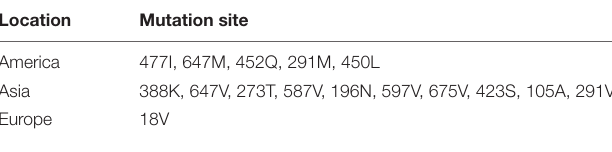
TABLE 3 | Relationship between mutation sites and geographic distribution of